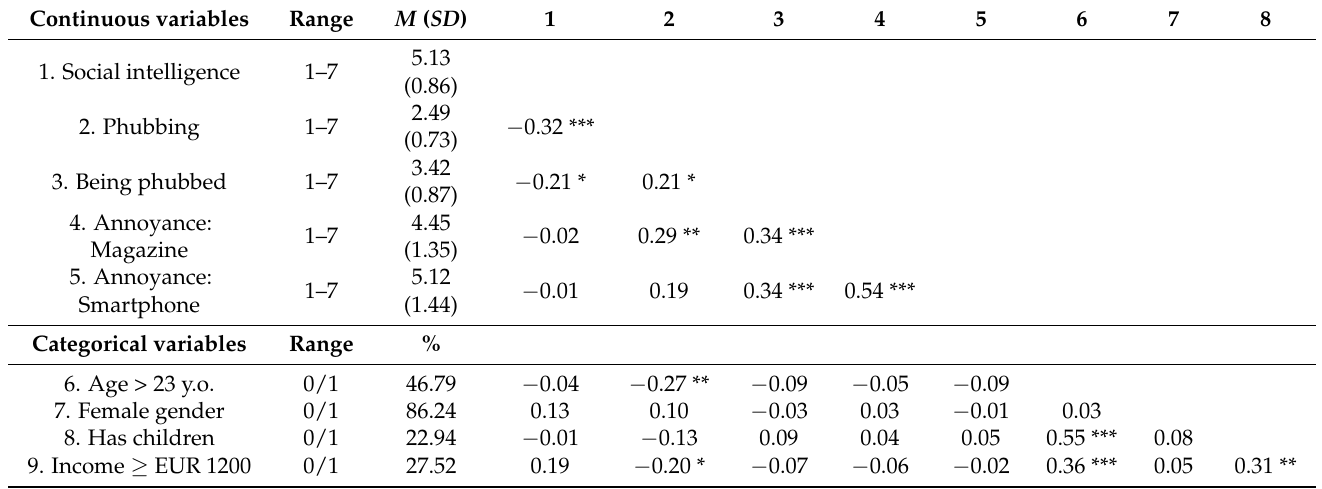
Table 2. Correlations and descriptive statistics for the main variables in sample